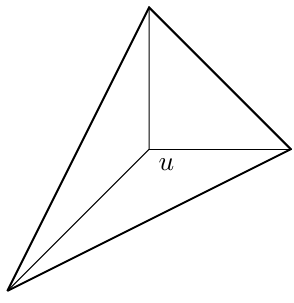
Figure 11 . Toric diagram for local P 2